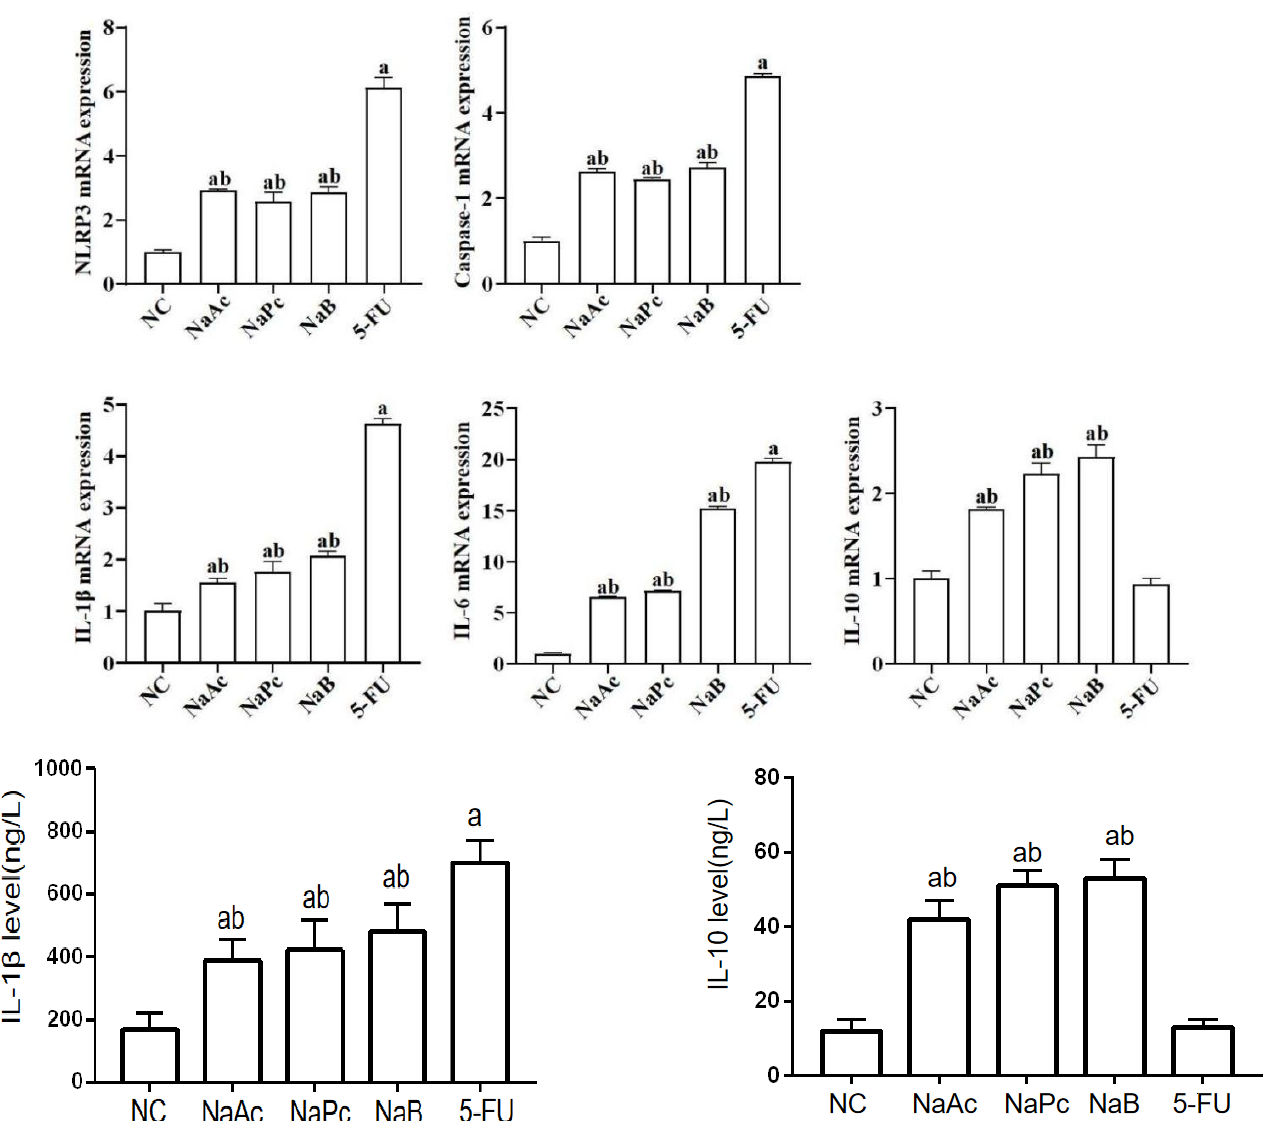
Figure 3. Effects of the SCFAs on inflammatory mediator expression by qRT-PCR and ELISA assay ( n = 3/group). The cells were pretreated with 100 µmol/L of SCFAs (NaAc, NaPc, and NaB) and then stimulated with 5 − FU (2.5 mmol/L). The mRNA expressions of NLRP3, Caspase − 1, IL − 6, and IL − 10 were determined by qRT-PCR, and the contents of IL − 1 β and IL − 10 were determined by ELISA. Each experiment was repeated at least three times. Data are expressed as the mean ± SEM. a— p < 0.05, vs. the NC group; b— p < 0.05, vs. the 5-FU group.